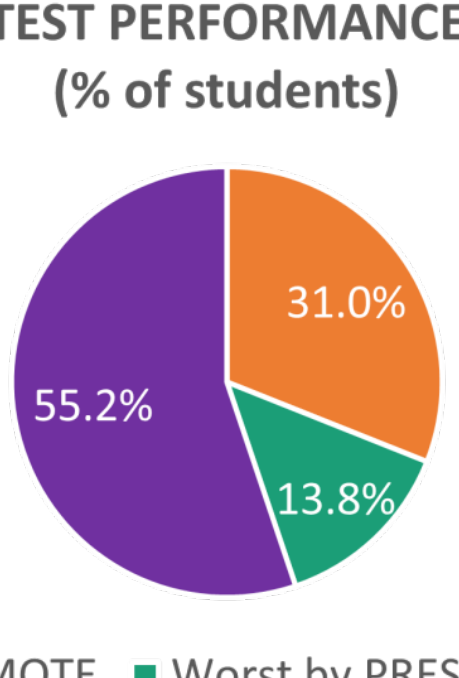
Figure 7. Percentage of right and wrong answers provided by the participants to the subjects covered in the In-presence ( left ) and Remote ( right ) conditions.